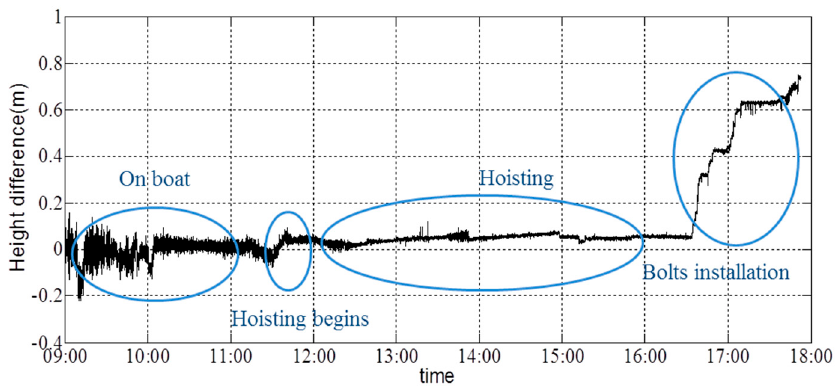
Figure 29. Height difference in the front/back direction.